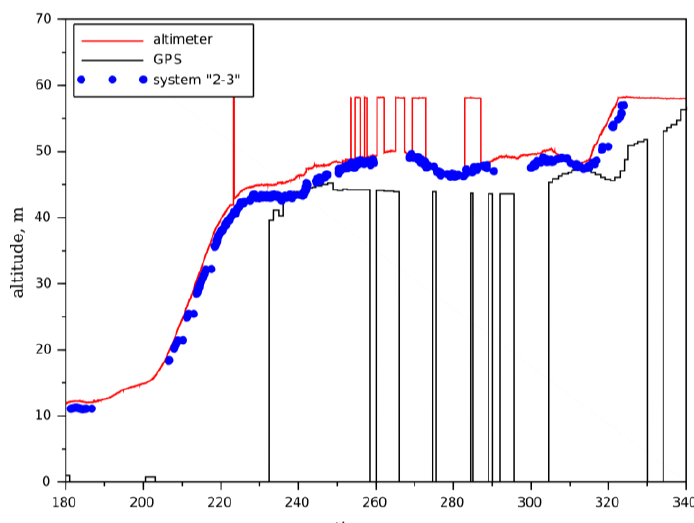
Fig. 6. Results of height measurement by various components of the